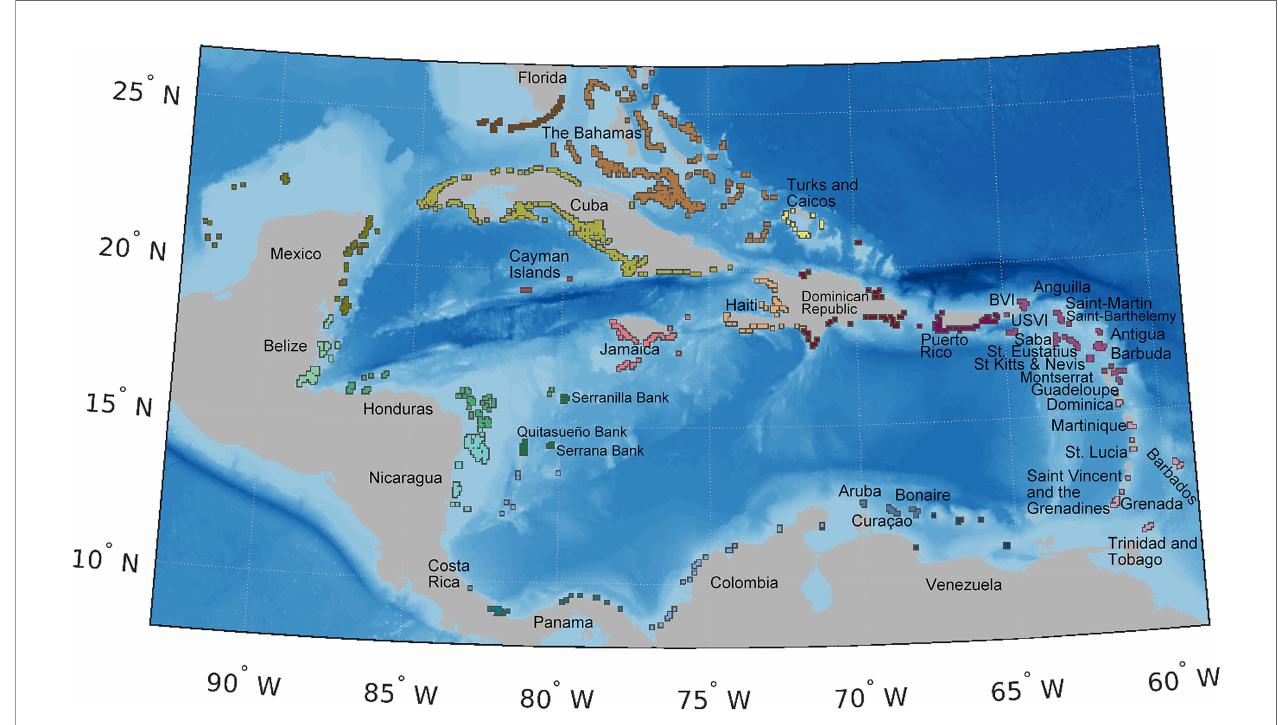
FIGURE 2 | Map of spawning and settlement habitat (polygons), color-coded by jurisdiction. Conch habitat is represented of 1359 8×8 km polygons (Holstein et al., 2014) based on shallow (depth less than 20 m) coral reefs locations from the Millennium Coral Mapping Project (Spalding et al., 2001; IMaRS-USF 2005; IMaRS-USF and IRD 2005; Andre ́ fouët, 2008; UNEP-WCMC et al., 2021). Individual habitats are buffered to facilitate visualization and are not represented to scale. Due to close proximity, some jurisdictions are referred by their regional location, as follows: 1) the Greater Antilles is composed by the Cayman Islands, Cuba, Dominican Republic, Haiti, Jamaica, Puerto Rico; 2) the Leeward Islands are Anguilla, Antigua and Barbuda, British Virgin Islands, United States Virgin Islands, Guadeloupe, Montserrat, Saba, Saint Barthe ́ lemy, Collectivity of Saint Martin, Sint-Eustatius, Saint Kitts and Nevis; 3) the Windward Islands are composed by Barbados, Dominica, Grenada, Martinique, Saint Lucia, Saint Vincent and the Grenadines, Trinidad and